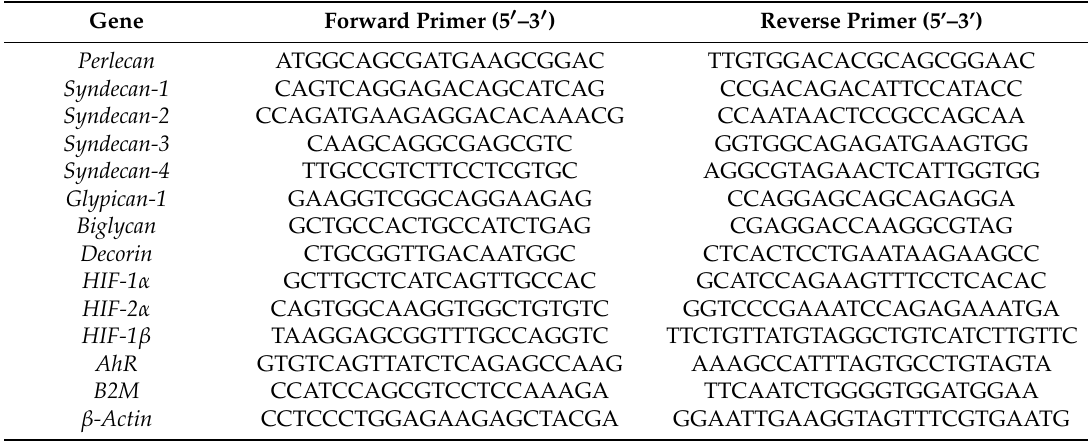
Table 1. Bovine gene-specific primers for